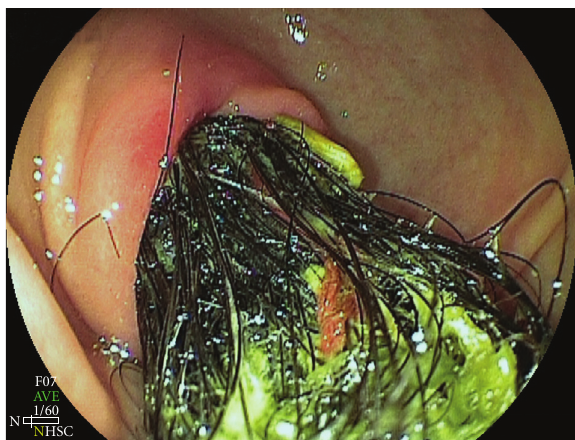
Figure 1: Endoscopic image of a trichobezoar extending into the pylorus.